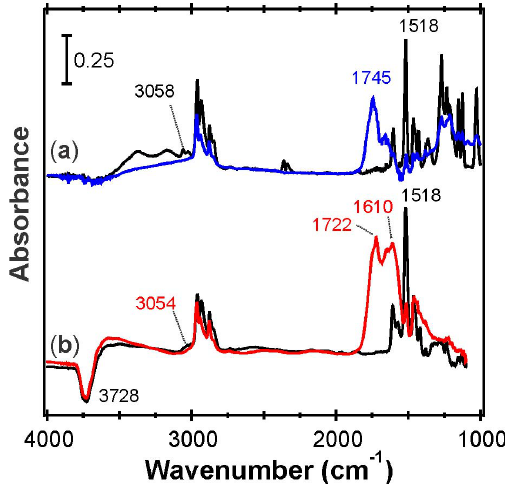
Fig. 3. DRIFTS spectra of 4-propylguaiacol adsorbed on (a) NaCl exposed to 551ppb O 3 at t = 0min (black) and 500min (blue), and (b) α -Al 2 O 3 exposed to 420ppb O 3 at t = 0min (black) and 500min